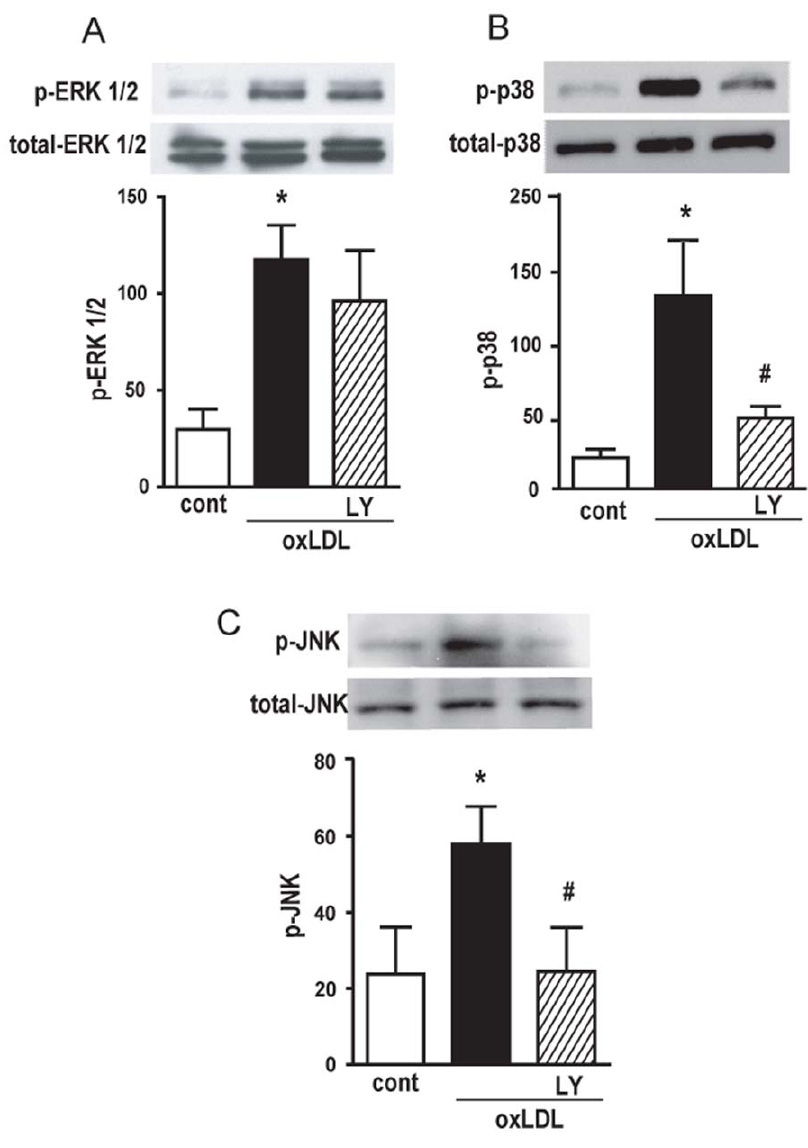
Figure 2. PI3k/Akt pathway is required for p38 and JNK MAPK activation induced by oxLDL. Adherent monocytes/macrophages were treated with LY294002 (10 m M, 30 min) and then stimulated with oxLDL (30 m g/mL) for 10 min. The MAPK Western blot analysis of cell lysates were performed using antibodies to phosphorylated and non-phosphorylated forms of ERK1/2, p38 and JNK (A, B and C, respectively). The autoradiographs show one representative experiment. Graph data are presented as mean 6 SEM of four donors. Protein expression was quantified by the AlphaEaseFC TM software V3.2 beta (Alpha Innotech). * p , 0.05 comparing oxLDL-stimulated with the non-stimulated cells (cont). # p , 0.05 comparing cells treated with LY294002 with non-treated